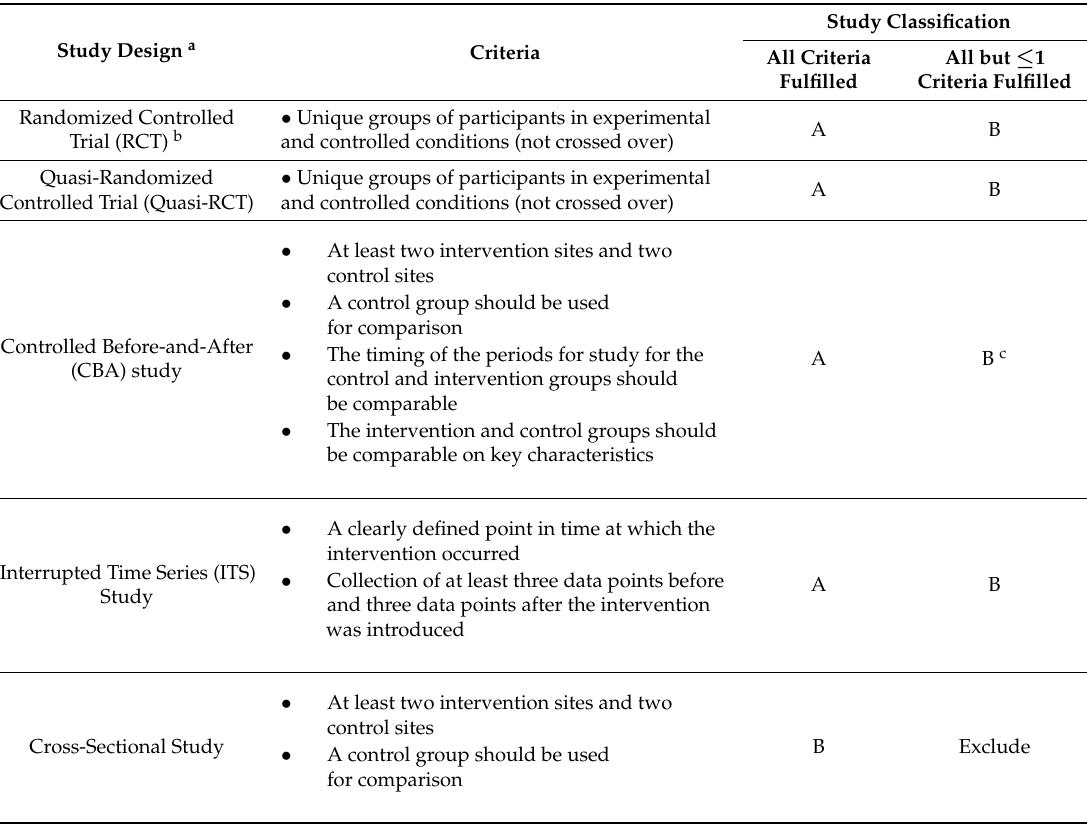
Table 1. Study designs eligible for consideration and criteria for